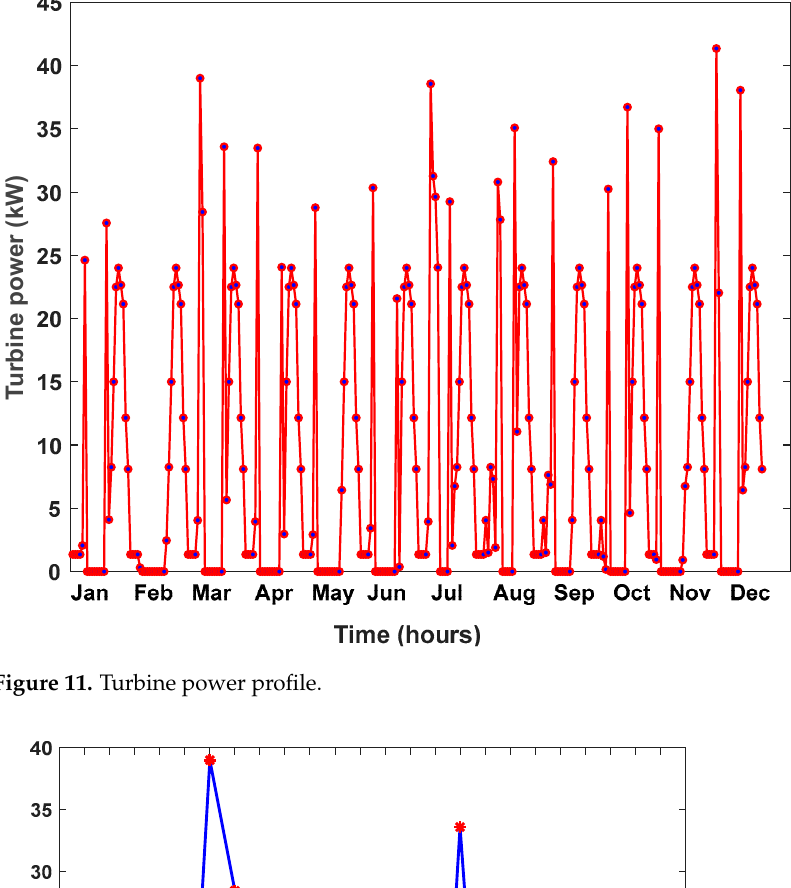
15 of 23 Figure 10. Daily profile of the pump power demand for the month of March.